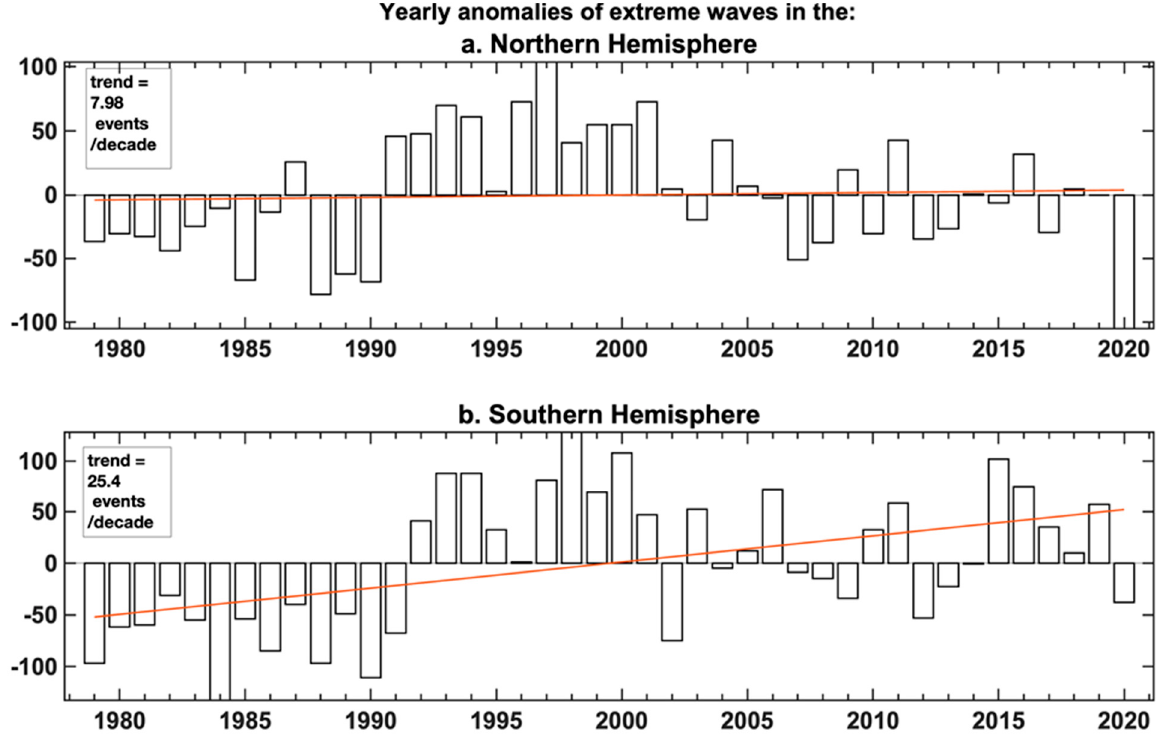
Figure 8. Yearly accumulated anomalies (bars) and long-term linear trends (orange lines) of extreme events occurrence in the Northern ( a ) and Southern ( b ) Hemispheres. The observed trend in the Southern Hemisphere was significant at the 95% confidence level according to a Mann-Kendall test.